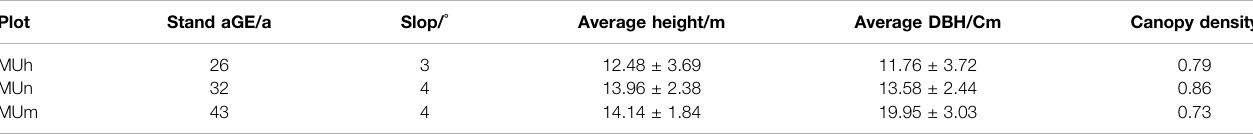
TABLE 1 | General information of sampling plots.